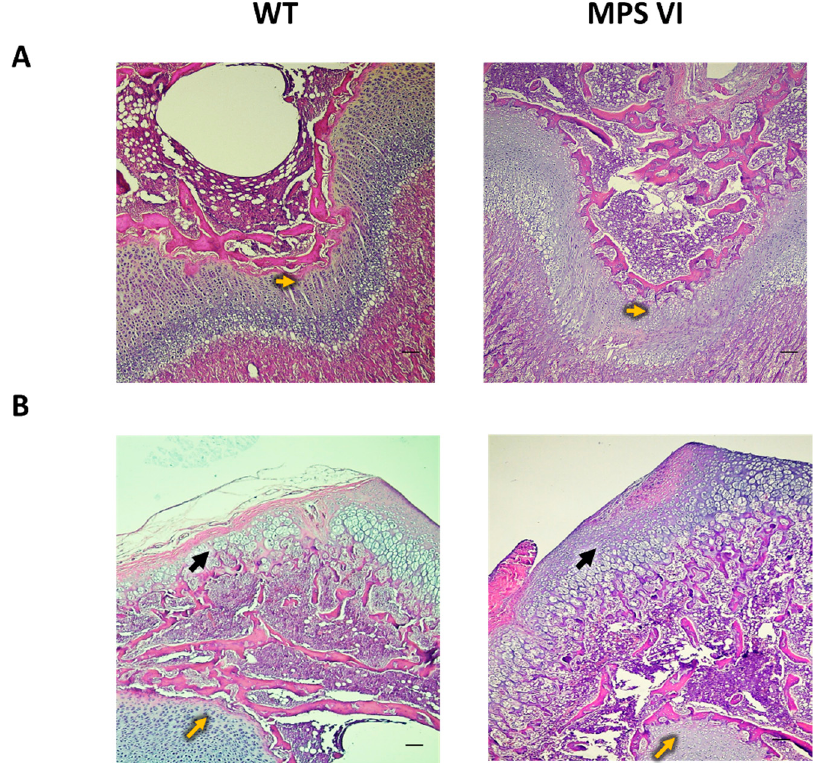
Figure 5. Microscopic images of distal femur epiphyses of WT and MPS VI animals. ( A ) Growth Plate; ( B ) Articular surface. Histological sections were stained with hematoxylin and eosin. Images are at 10× magnification. Scale bars correspond to 100 µm. Yellow arrows show epiphyseal side of the growth plate. Black arrows show the articular surface.